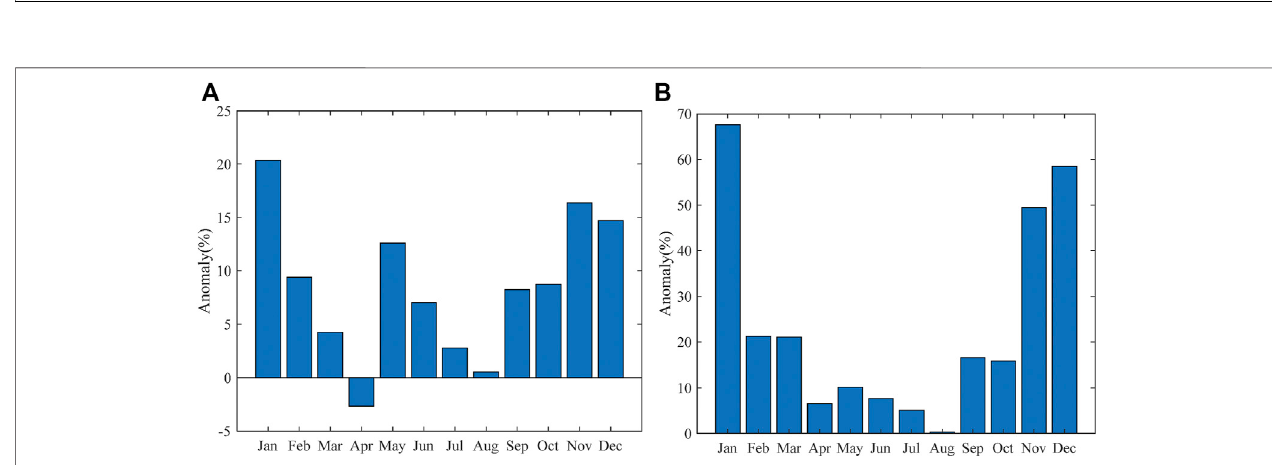
FIGURE 11 | Averaged monthly precipitation anomaly in the future period of 2021 – 2050 (A) and 2061 – 2090 (B) .